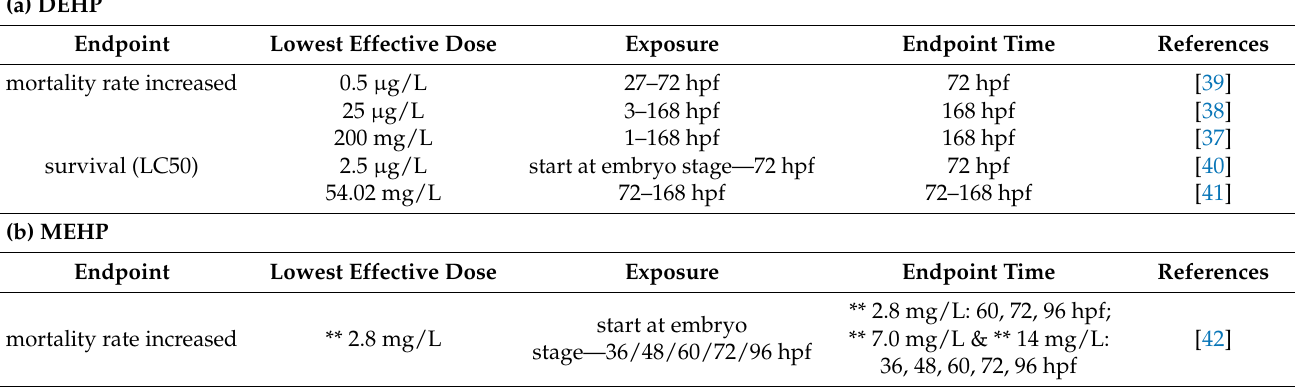
Table 1. Lethal effects from acute exposures to (a) DEHP and (b) MEHP on zebrafish embryos. ** The concentration was converted from nM or µ M using the molar mass of MEHP 278.34